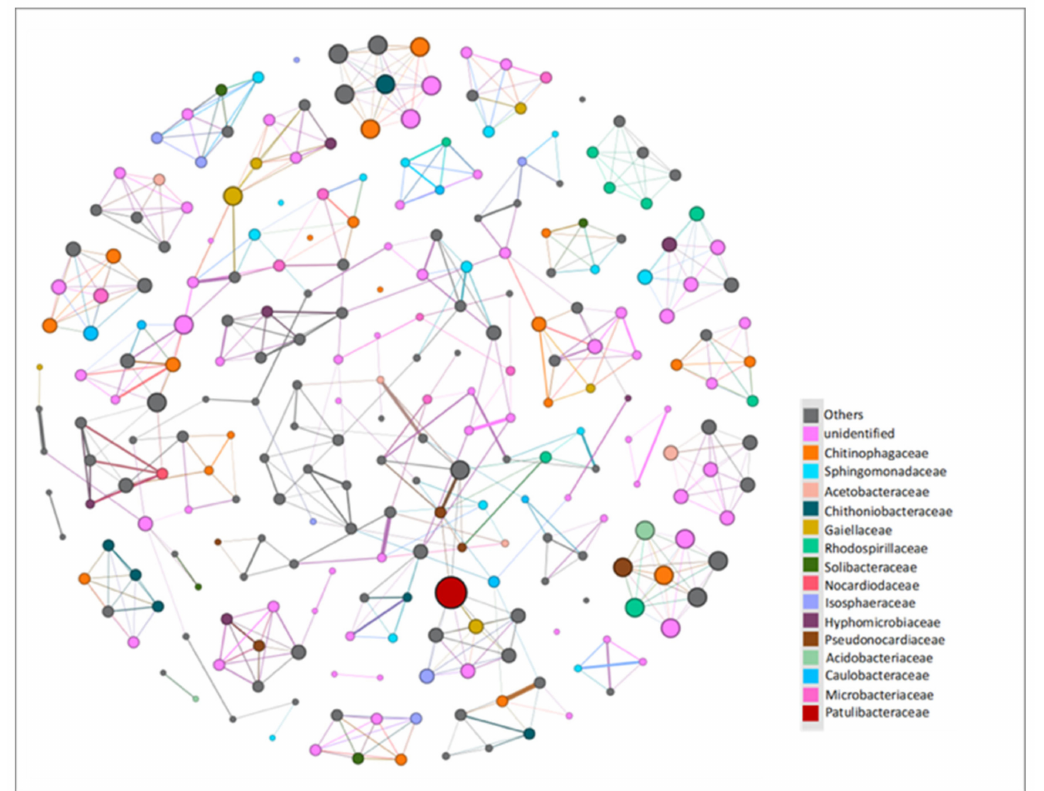
Figure 5. Co-occurrence network of the main OTUs based on correlation analysis. Nodes correspond to microbial OTUs and edges to the microbial associations. A connection stands for a strong (Spear- man’s ρ > 0.6) and highly significant ( p < 0.001) correlation. The size of each node is proportional to the number of